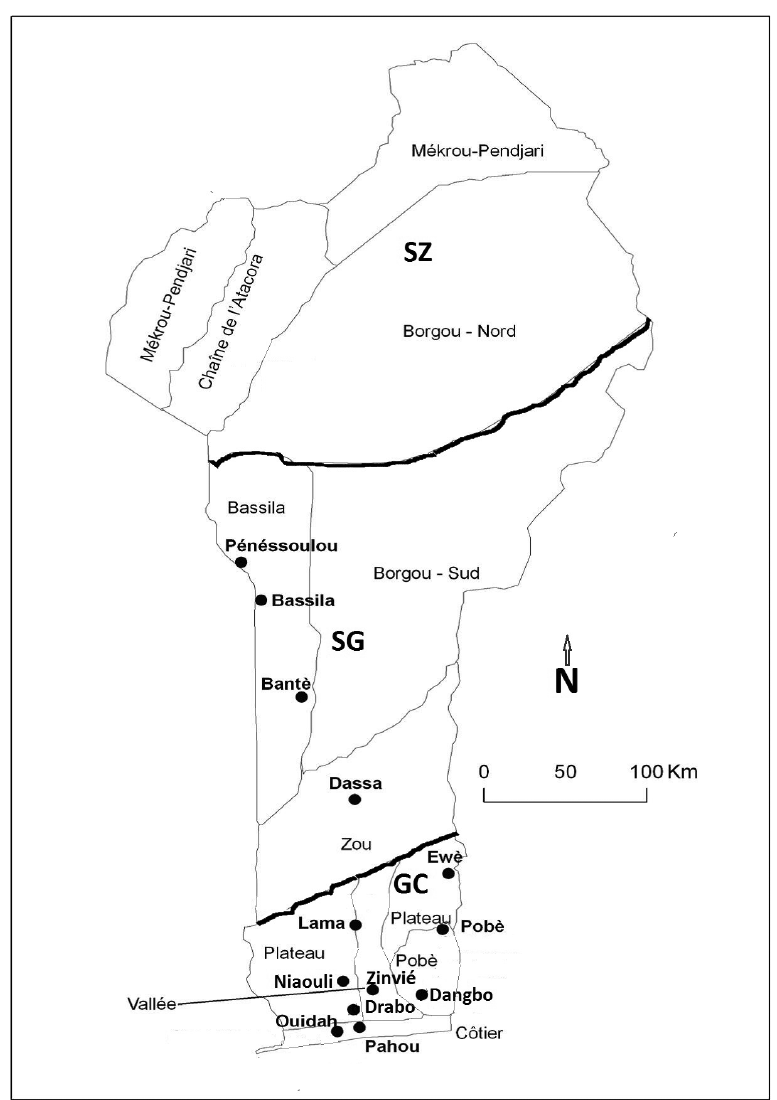
Figure 2. Map of Benin with phyto-ecological zones with GC, SG and SZ as in Figure 1, phyto-geo- graphical districts according to Adomou (2011) in small